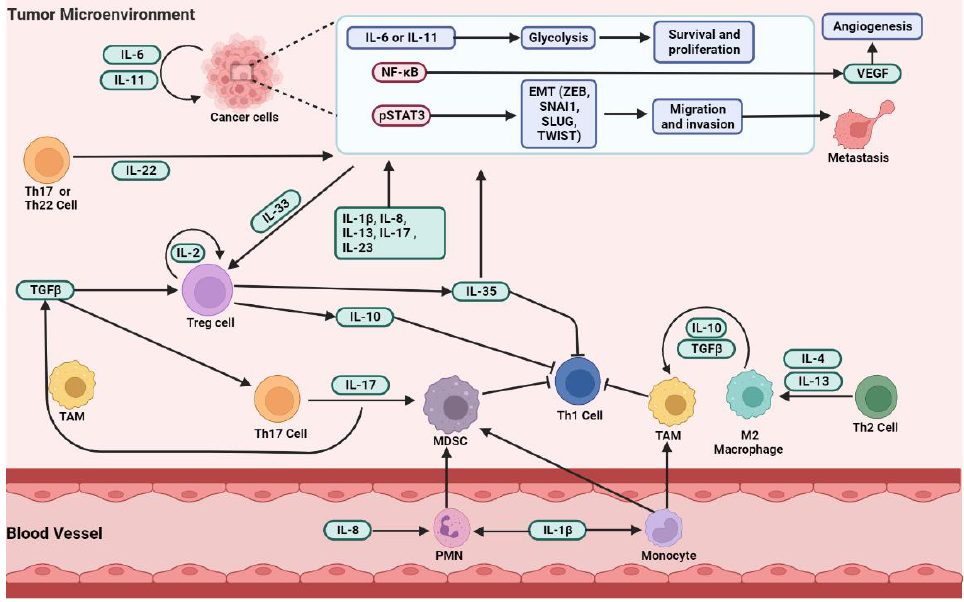
Figure 4. The effect of cytokines in the tumor microenvironment, created by Biorender.com (accessed on 26 August 2022), adapted by Briukhovetska et al. [185]. Immune evasion and tumor progression depend on cancer cell-intrinsic and -extrinsic cytokine signaling. It is shown that OC overexpresses certain cytokines, for example, IL-6, which act in an autocrine way to upregulate glycolysis and induce metabolic reprogramming, nuclear factor kappa- κ B (NF- κ B), and signal transducer and activator of transcription 3 (STAT3). These pathways in change can lead to epithelial–mesenchymal transition (EMT), increased proliferation, reduced apoptosis, increased migration, and the production